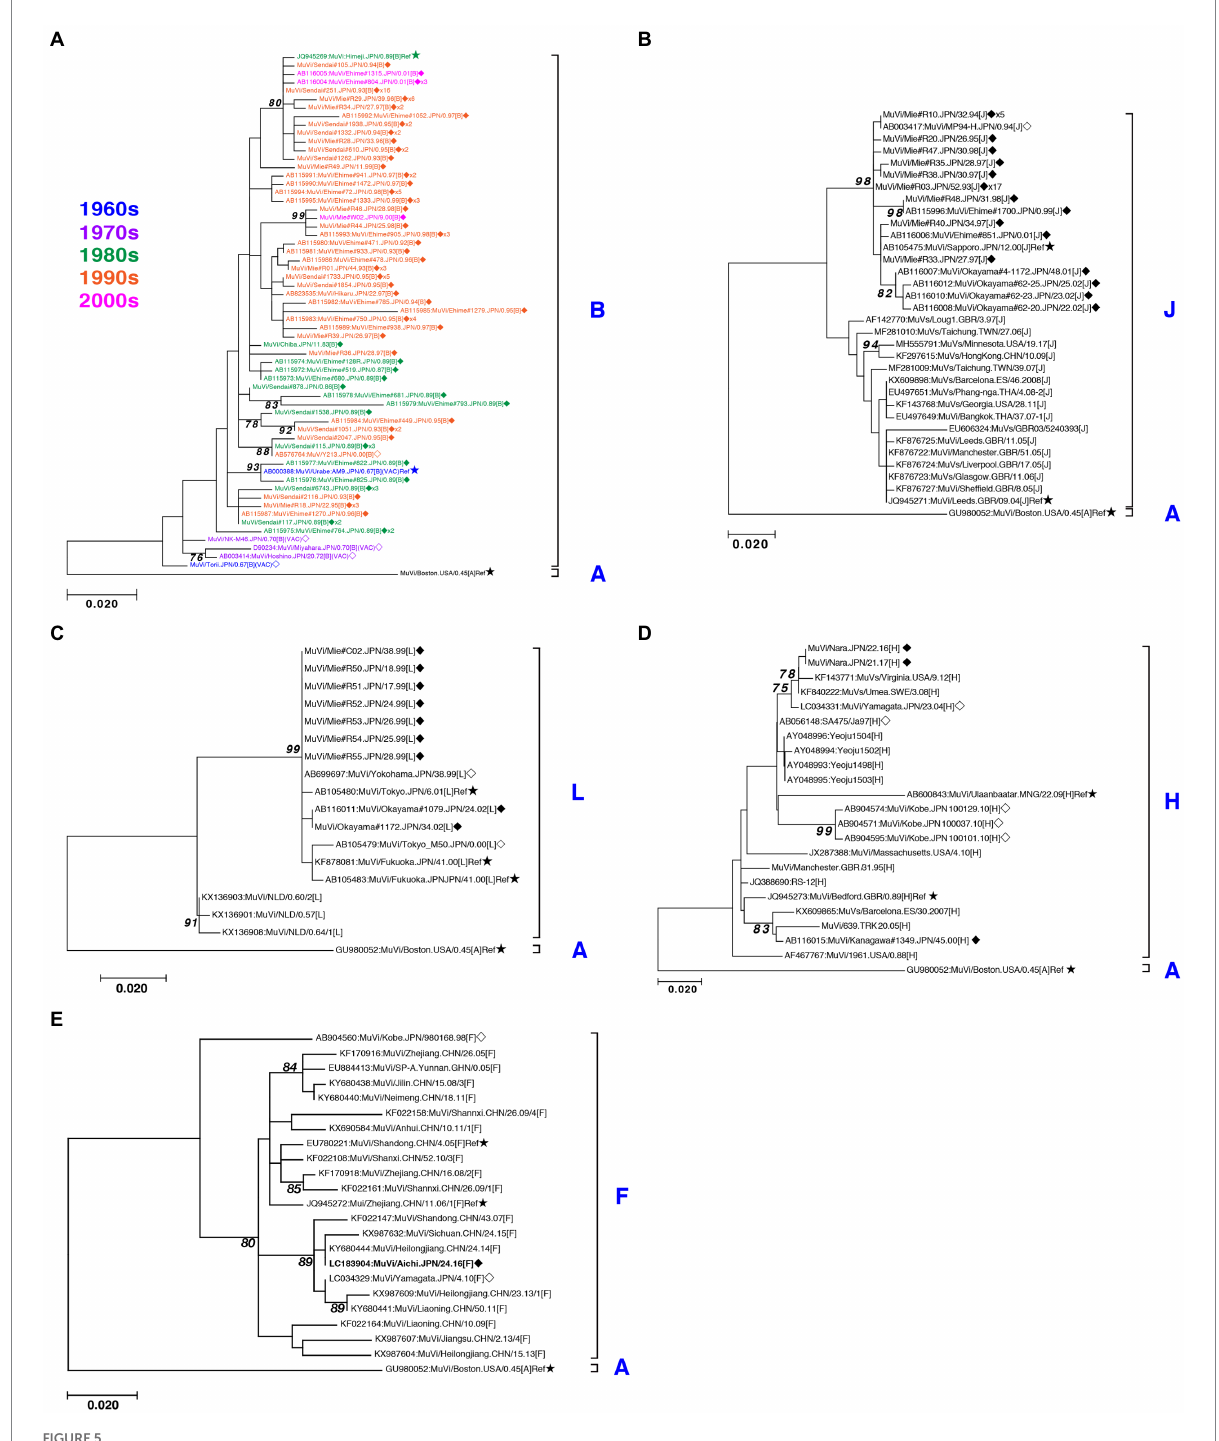
FIGURE 5 Maximum-likelihood phylogenetic tree of the genotype B (A) , J (B) , L (C), H (D) , and F (E) based on the SH gene sequences. The World Health Organization (WHO) reference strains are indicated by stars ( ★ ). The strains collected in this study are indicated by a filled rhombus ( ◆ ). The domestic related strains are indicated by an empty rhombus ( ◇ ). The trailing number of the strain name indicates the number of isolates with identical sequences in the study. Bootstrap values >75% are indicated on the trees. The genotype B strains collected in the study are color coded according to the decade of isolation (1960s in blue, 1970s in purple, 1980s in green, 1990s in orange, and 2000s in